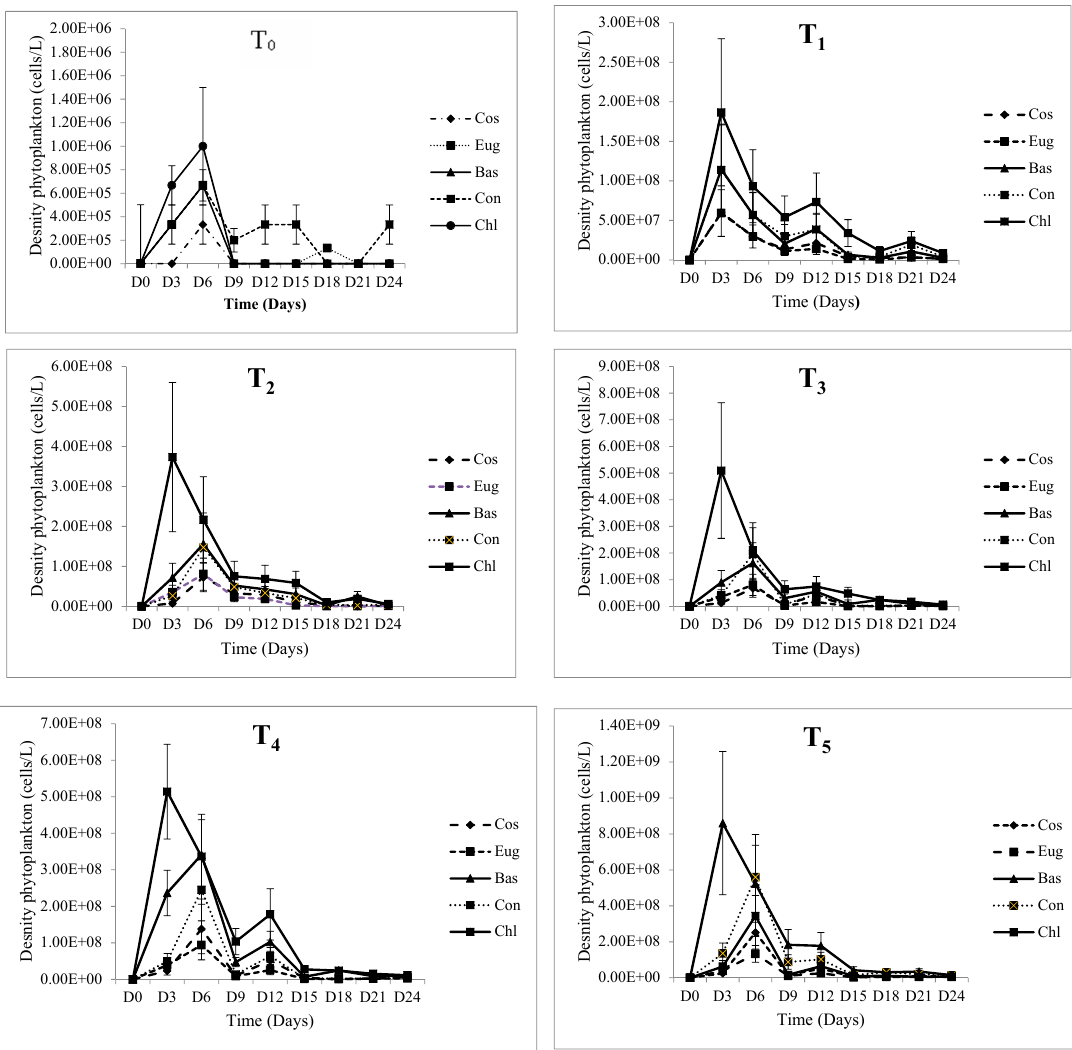
Figure 3. Phytoplankton density evolution in the classes per treatment (dose of rabbit manure). Cos: Coscinodiscophyceae, Eug: Euglenophyceae, Bac: Bacillariophyceae, Con: Conjugatophyceae, Chl: Chlorophyceae. T0 (the control), T 1 , T 2 , T 3 , T 4 , T 5 corresponding respectively to 0, 300, 600, 900, 1200, 1500 g of dry rabbit manure (RM).